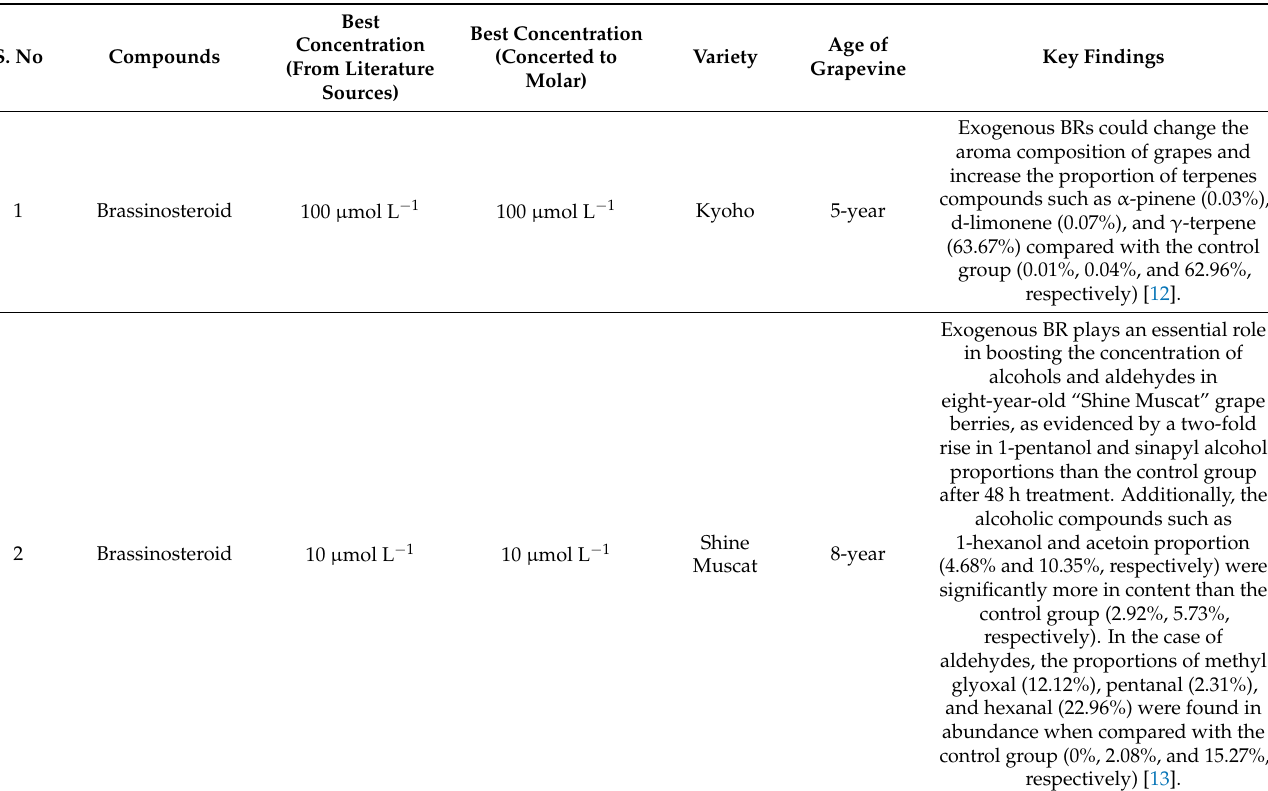
Table 3. Impact of exogenous brassinosteroid/brassinolide on the production of aroma in different grape